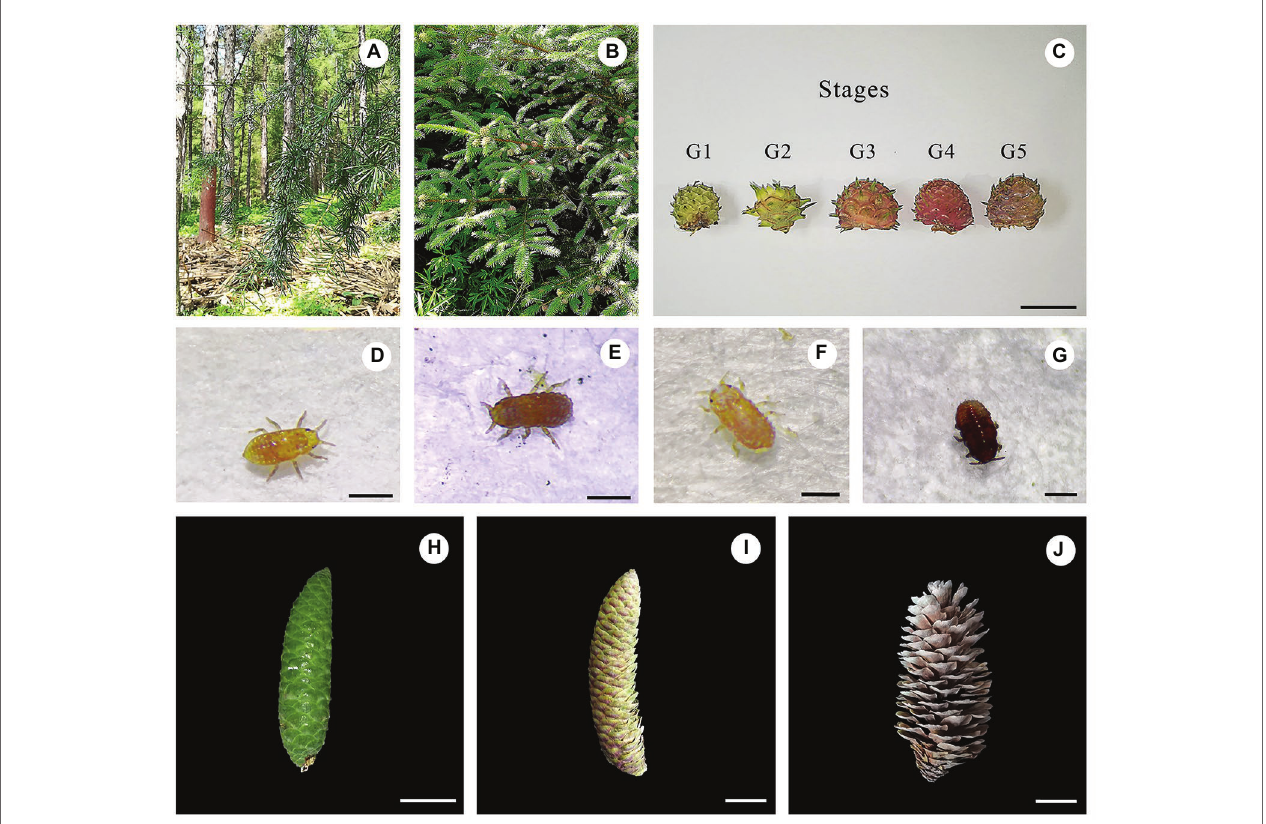
FIGURE 1 | Field and microscope observations of the larch adelges Adelges laricis laricis Vallot and the cones of Picea koraiensis . Cauline galls induced by A. laricis laricis Vallot on P. koraiensis . (A) Field habit of Larix kaempferi , a secondary host of A. laricis laricis . (B) Field habit of P. koraiensis , a first host of A. laricis laricis . (C) Morphological characteristics of cauline galls caused by A. laricis laricis on P. koraiensis at different developmental stages of G1–G5. (D–G) A. laricis laricis Vallot isolated from the gall tissues of P. koraiensis . (H–J) P. koraiensis cones at different developmental stages of F1–F3. Scale bars = 2 cm for (C) and (H–J) ; 0.25 mm for (D) and (E) ; 0.4 mm for (F) ; 0.35 mm for (G)